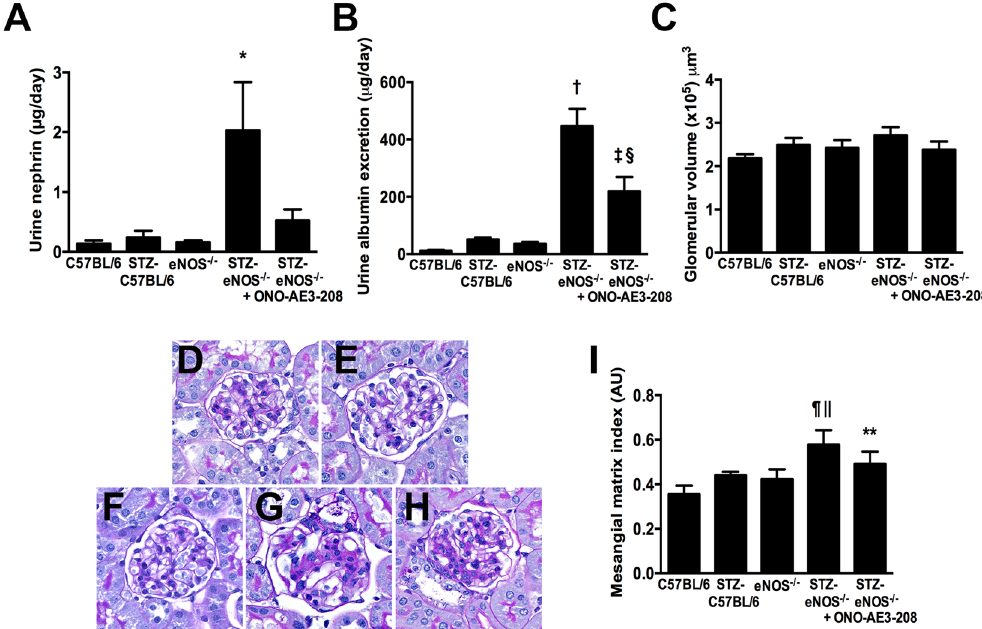
Figure 1. Effect of ONO-AE3-208 in non-diabetic and streptozotocin (STZ)-diabetic eNOS knockout (eNOS − / − , C57BL/6 genetic background) mice (n = 6/group). ( A ) Urine nephrin excretion after two weeks. ( B ) Urine albumin excretion after three weeks. ( C ) Glomerular volume after three weeks. ( D – H ) Representative photomicrographs of periodic acid-Schiff stained kidney sections from ( D ) C57BL/6 + vehicle, ( E ) STZ- C57BL/6 + vehicle, ( F ) eNOS − / − + vehicle, ( G ) STZ-eNOS − / − + vehicle, ( H ) STZ-eNOS − / − + ONO-AE3-208. Original magnification × 400. (I) Mesangial matrix index. AU = arbitrary units. * p < 0.01 vs. all other groups; † p < 0.0001 vs. C57BL/6 + vehicle, STZ-C57BL/6 + vehicle, or eNOS − / − + vehicle; ‡ p < 0.001 vs. C57BL/6 + vehicle or STZ-eNOS − / − + vehicle; § p < 0.01 vs. STZ-C57BL/6 + vehicle or eNOS − / − + vehicle; ¶ p < 0.01 vs. C57BL/6 + vehicle; || p < 0.05 vs. STZ-C57BL/6 + vehicle or eNOS − / − + vehicle; ** p < 0.05 vs. C57BL/6 + vehicle;.